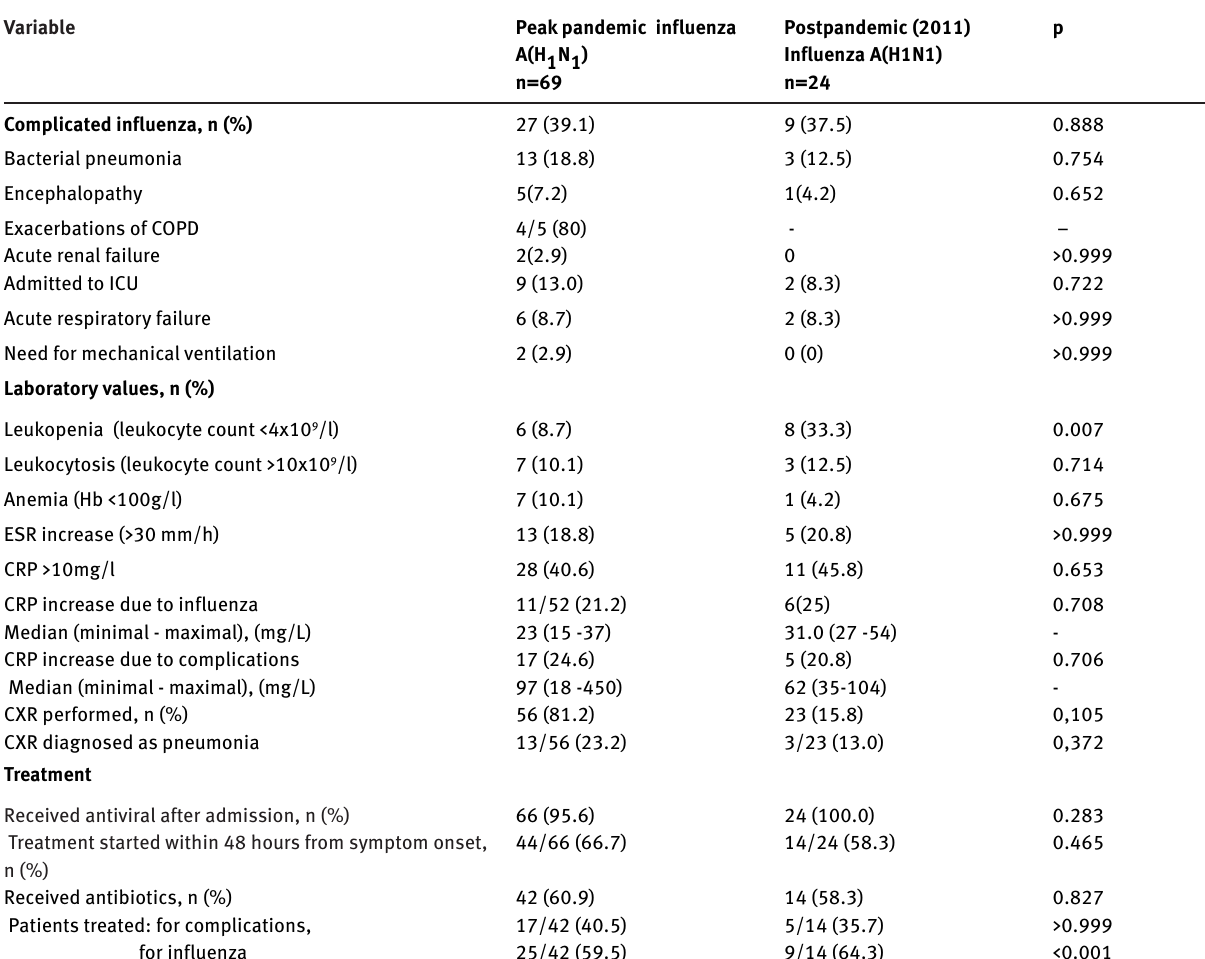
Table 3: Complications, outcomes, laboratory values and treatment among patients with influenza A(H1N1)pdm09 or postpandemic